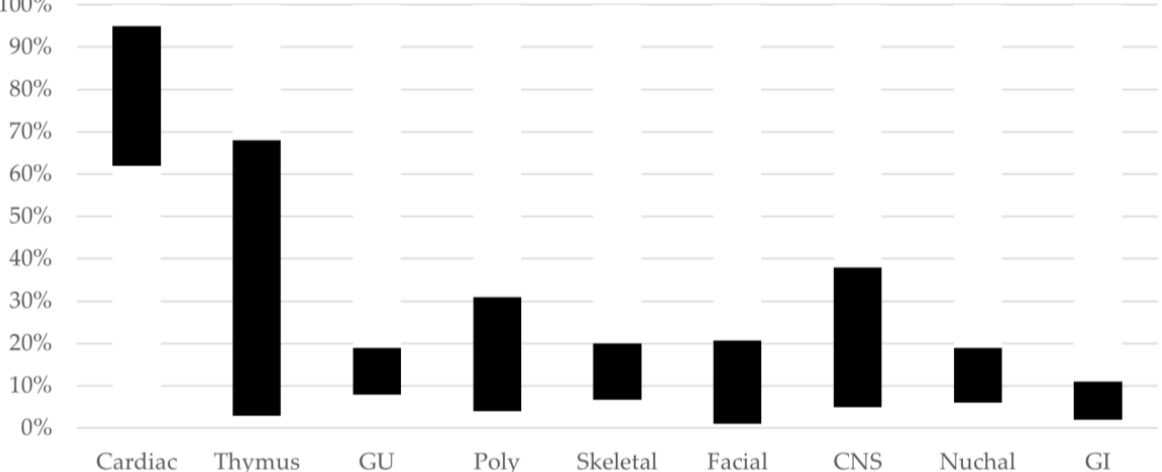
Figure 4. 22q11.2DS Structural Findings. Range of proportion of fetuses with prenatal structural findings in nine categories, later found to have a diagnosis of 22q11.2DS. Based on data from studies with 40 or more patients [6,11,38,39,41]. Legend: GU, genito-urinary tract; Poly: polyhydramnios; CNS: central nervous system, GI: